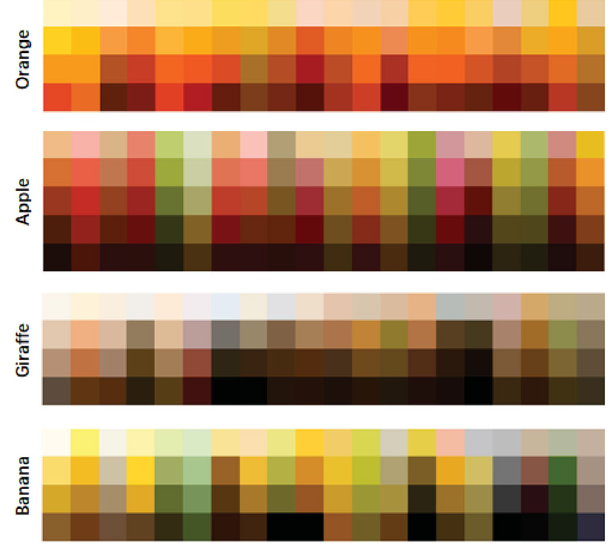
Fig. 4 Examples of recommended palettes. In each category, a column of colors corresponds to a recommend palette; 20 palettes are shown for each